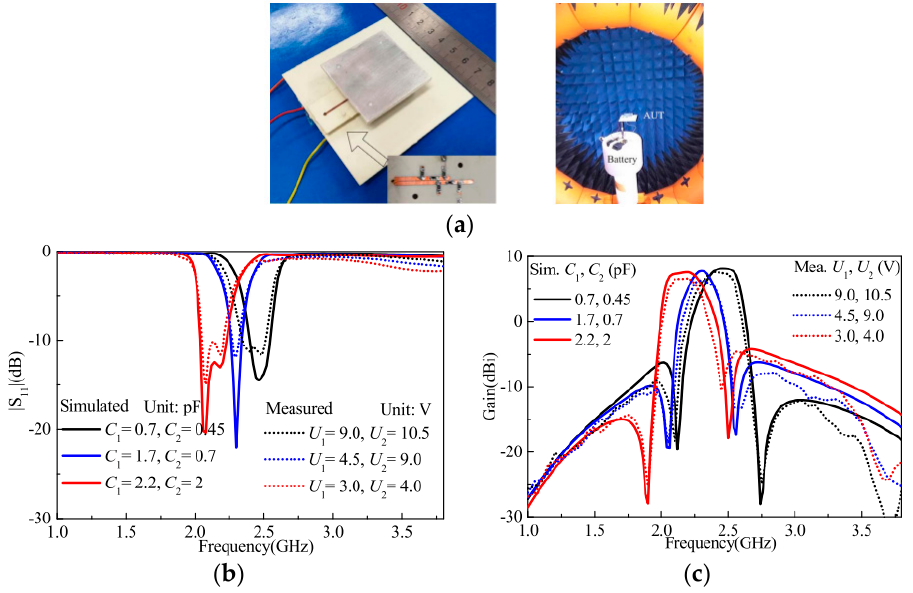
Figure 11. The reconfigurable filtering antenna reproduced from [77]. 2020, IEEE: ( a ) prototype structure; ( b ) S-parameter performance; ( c ) boresight gain performance.